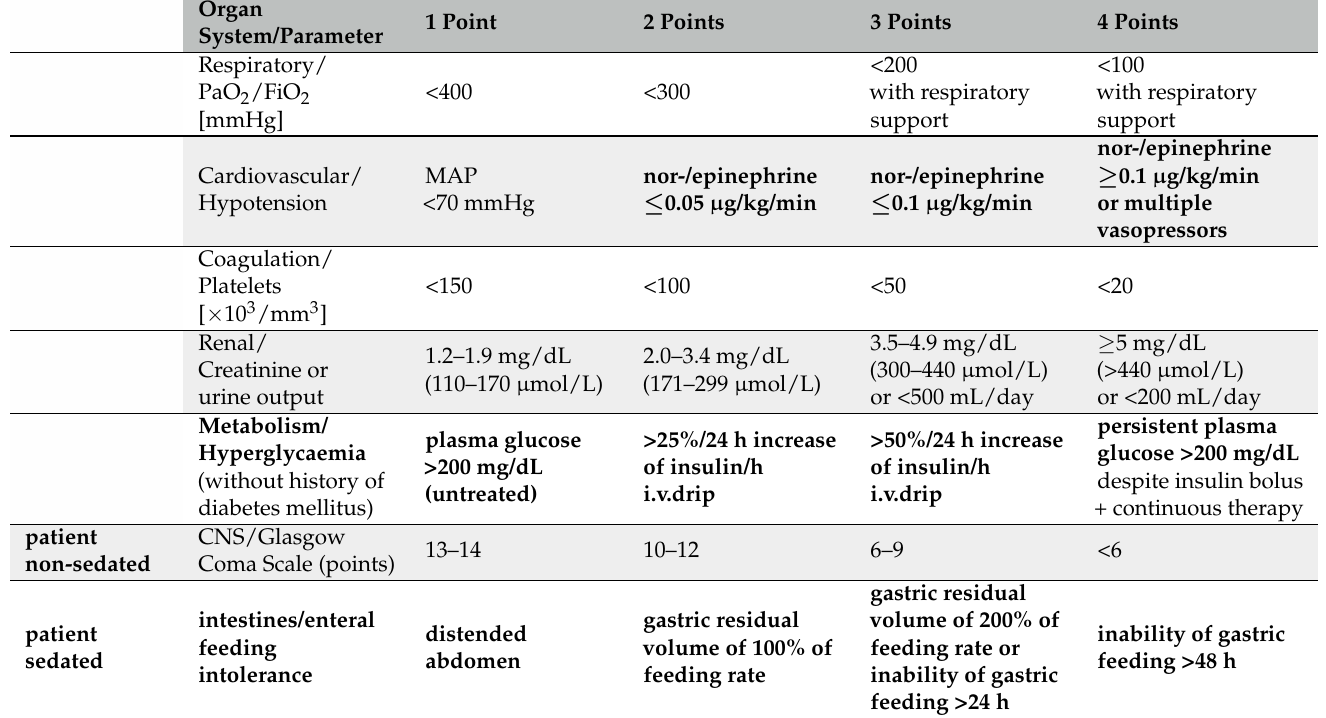
Table 2. Burn SOFA score: Increases of ≥ 2 points could indicate deterioration of organ failure. bold letters : modification compared to the original SOFA